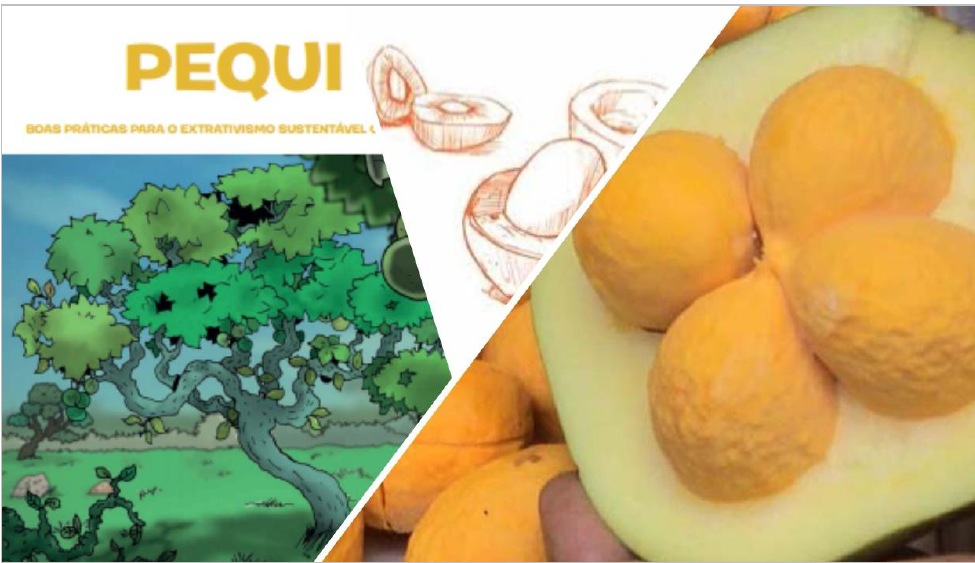
Figure 6. Best practices for the sustainable harvesting and management of pequi ( Caryocar brasiliense Cambess), common to Brazil’s Cerrado region. The guidelines are produced by the Ministry of Agriculture, Livestock and Supply (MAPA) in support of producers/extractivists intending to take part in the public procurement schemes.